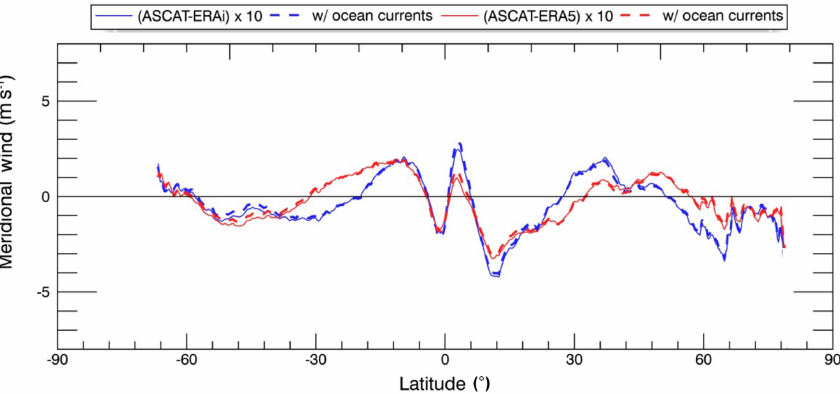
Figure 11. Zonally averaged mean meridional wind differences between ASCAT and ERA-Interim (blue line) and ERA5 (red line) first- guess winds over 2016, before (continuous lines) and after (dashed lines) the ocean current correction. Note that differences have been scaled by